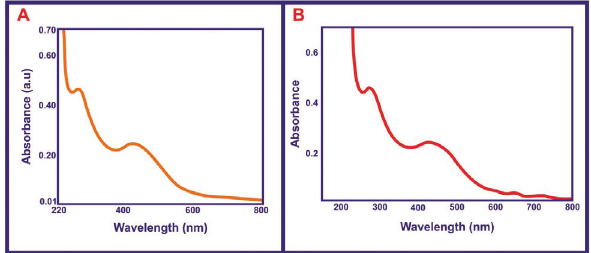
Figure 5: UV-Vis absorption spectra of Ag NPs of (a) A. bilimbi leaf and (b) Plum fruit.